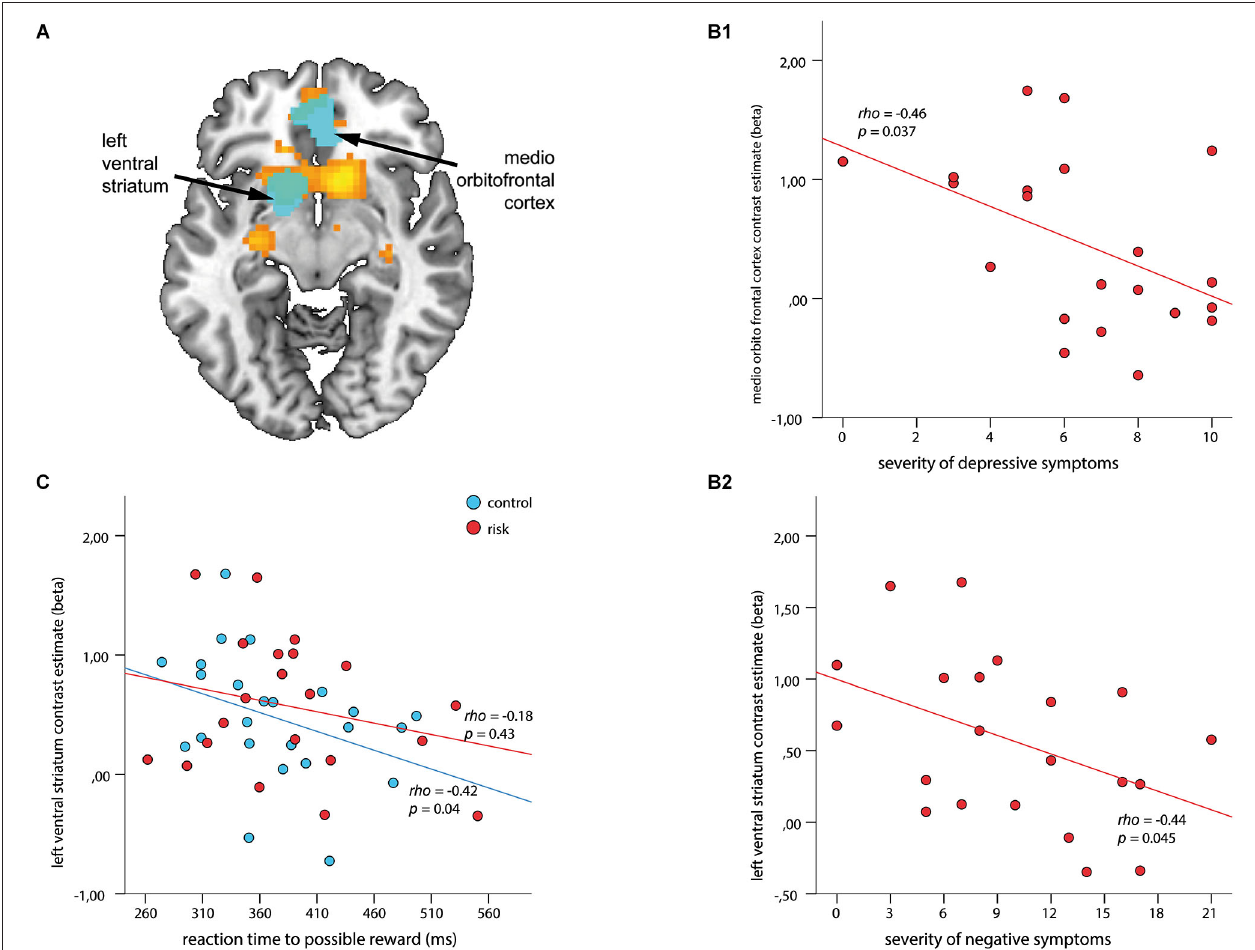
negative association between contrast estimates within the medio orbitofrontal cortex and severity of depressive symptoms (B1) , and the left VS and severity of negative symptoms (B2) ( ρ > − 0.44, p < 0.045). (C) Signal in the left VS revealed a significant inverse association with RT in healthy controls (blue; ρ = − 0.42, p = 0.04) but not for subjects at risk for psychosis (red; ρ = − 0.18, p =